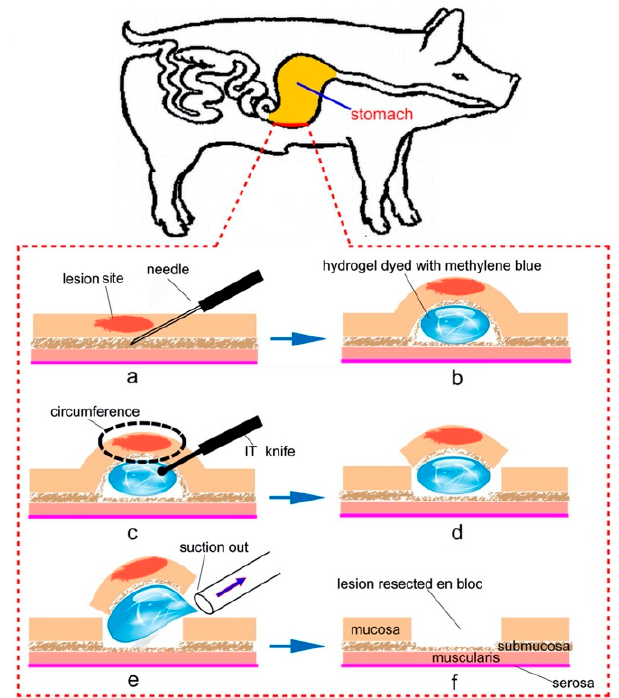
Figure 6. Schematic image of the application of thermoresponsive hydrogels as a submucosal cushion for endoscopic submucosal dissection (ESD): ( a ) and ( b ) injection of thermoresponsive hydrogels